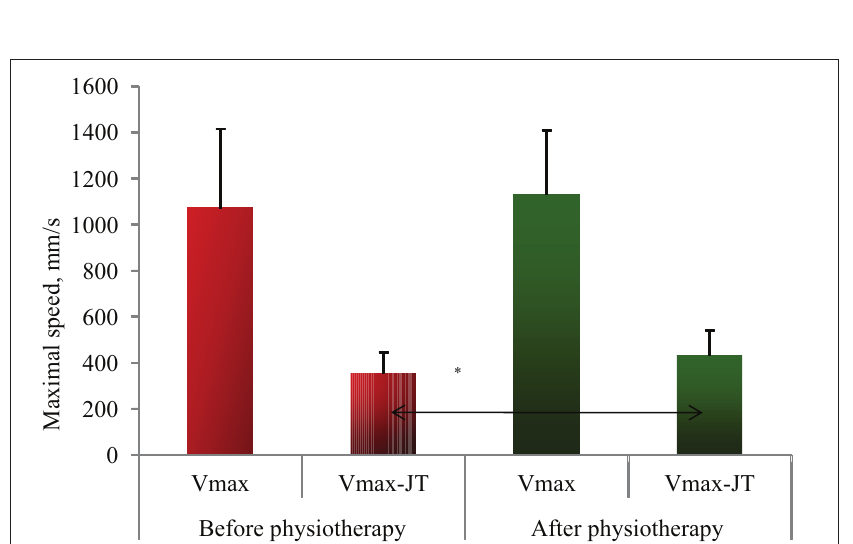
Figure 2. Average speed (mm/s) in patients with Parkinson’s disease performing a task of 5 sets of 20 repetitions before and after physiotherapy